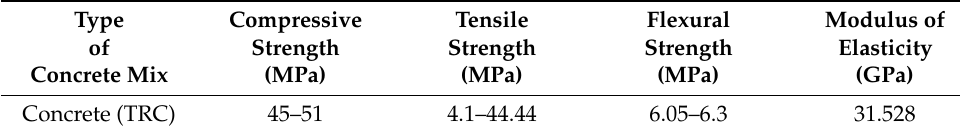
Table 5. Mechanical properties of